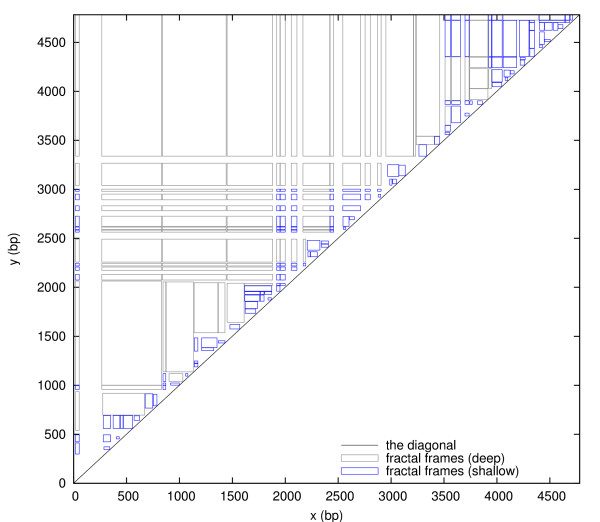
The set F of all fractal frames plotted in the xy-plane. The fractal frames (a, b) ∈ F are colored to distinguish those with depths D(a, b) ≥ Dmax (grey) and D(a, b) <Dmax (blue), thus illustrating the subsets Fd and Fs, respectively. Frames with side lengths below 20 bp are not shown to unclutter the figure.